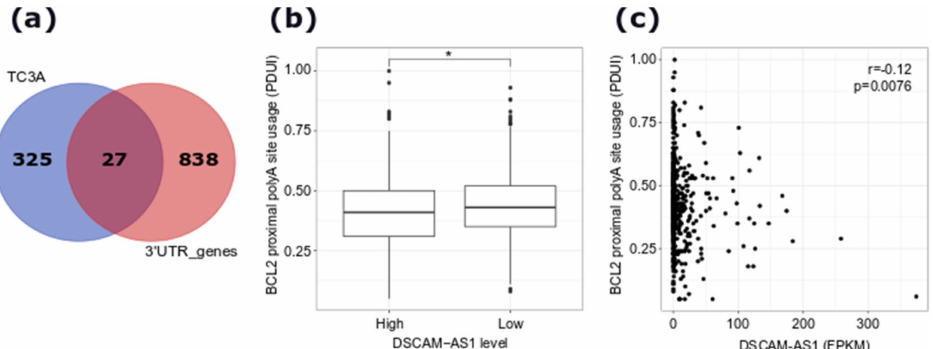
Figure 4. ( a ) Venn diagram showing the overlap between the genes with a di ff erential polyA site usage and 3 (cid:48) UTR regulation in our dataset and those retrieved from The Cancer 3 (cid:48) UTR Atlas (TC3A) database with di ff erential 3 (cid:48) UTR usage showing correlation with DSCAM-AS1 expression in BCs. ( b ) Boxplot showing the level of BCL2 proximal polyA site usage from TC3A database data considering luminal BCs characterized by a high or a low DSCAM-AS1 expression; *, Wilcoxon rank-sum test p -value < 0.05. ( c ) Scatterplot showing the relationship between BCL2 proximal polyA site usage index and DSCAM-AS1 expression (in FPKM) in BC samples retrieved from the TC3A database. Proximal to Distal polyA site Usage Index